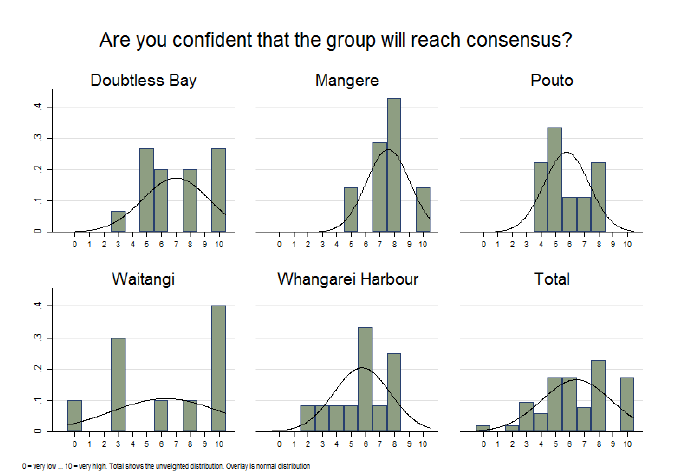
Figure A1.4 Results from the Northland processes at the same point in time, “Confidence in reaching